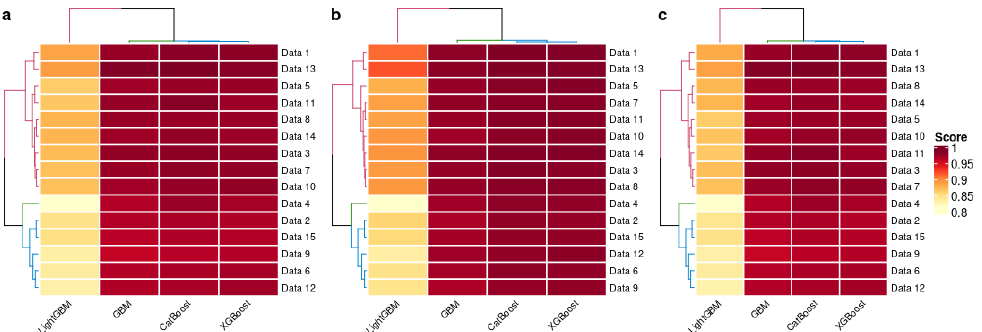
Figure 4. Hierarchical clusters (shown in three distinct colors) of algorithms and balanced data sets in terms of ( a ) MCC, ( b ) AUC, and ( c ) F1 metrics. The color in each cell represents the corresponding performance value (light yellow: low; dark red: